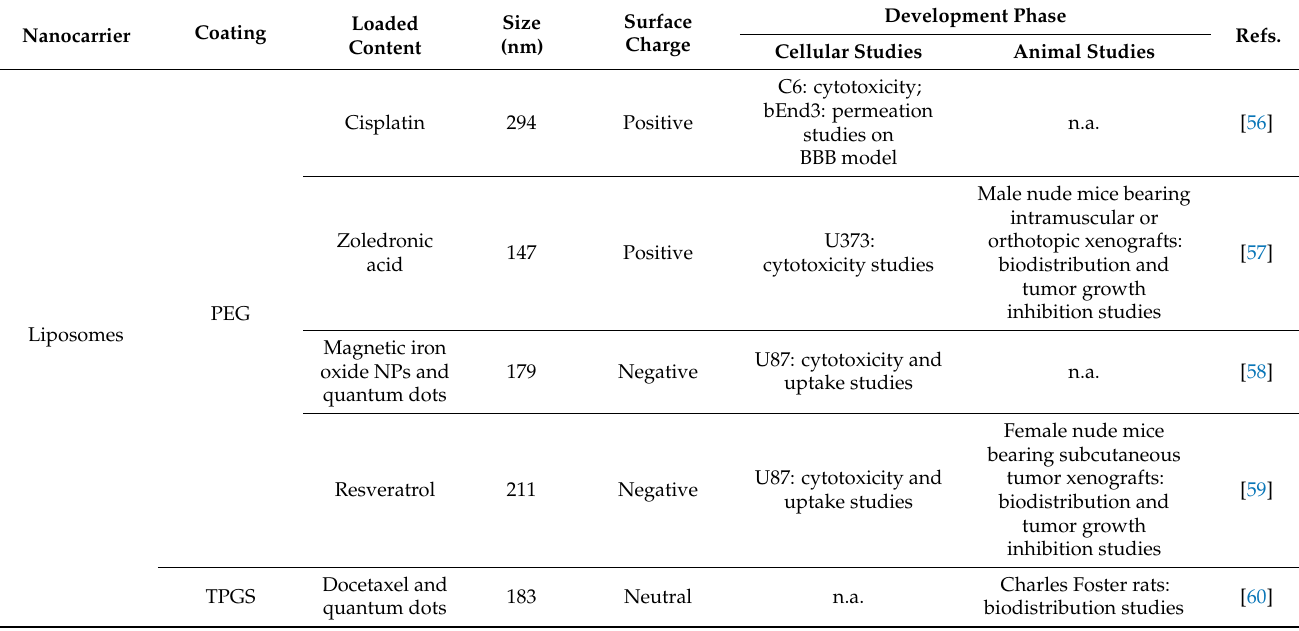
Table 2. Currently developed transferrin-modified nanosystems for GBM therapy.